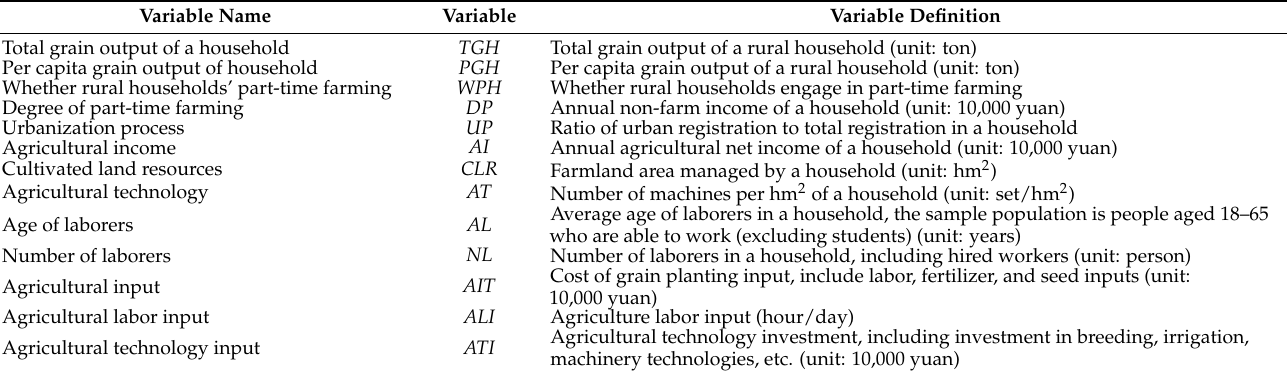
Table 1. Variable